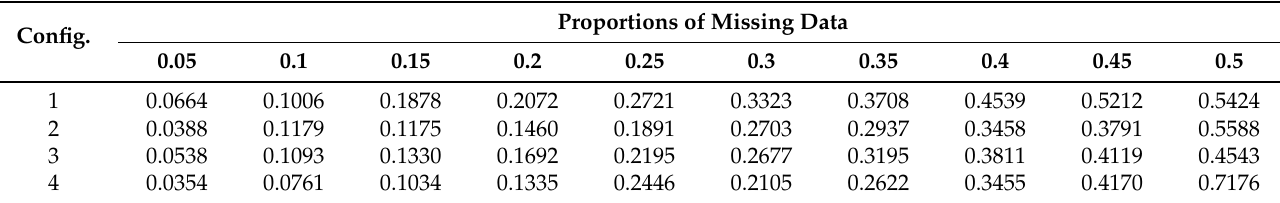
Table 3. Theoretical upper bounds.